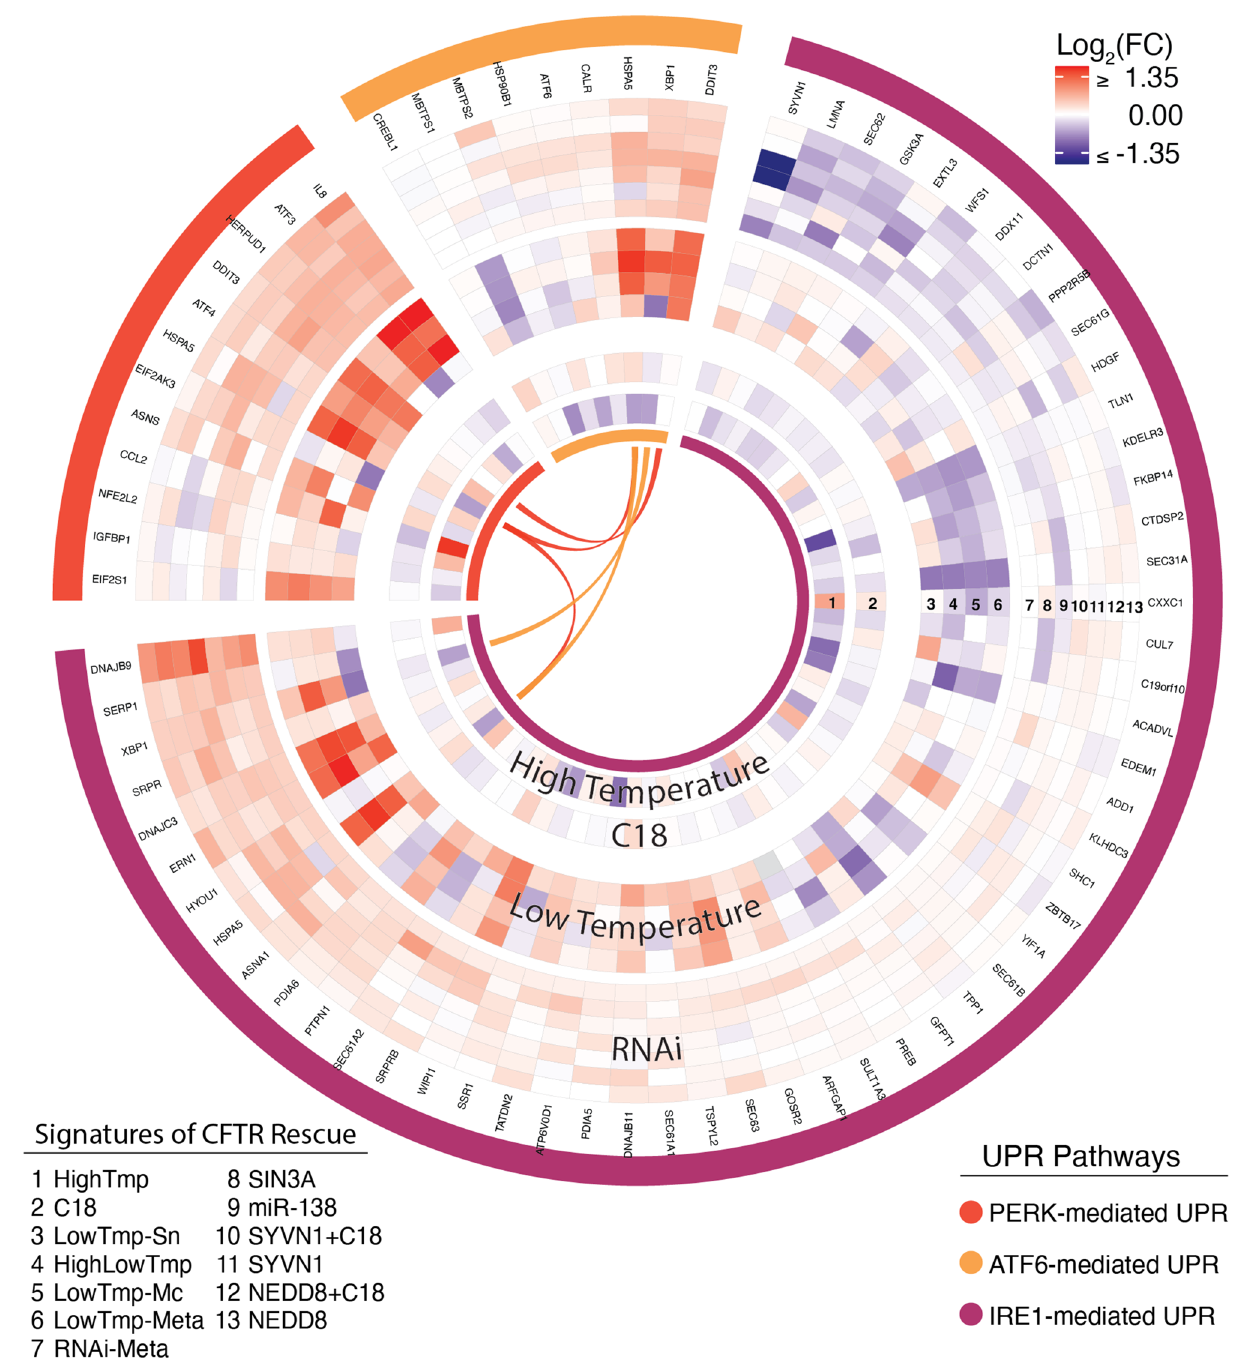
Figure 5. RNAi and low temperature, but not C18 or high temperature, induce consistent UPR transcriptional activation. “Columns” emanating from the center represent genes, which are grouped according to pathways, as indicated by the colors in the outermost circle. Concentric circles represent individual signatures and/or the core meta-analysis signatures, as indicated by the numbered legend. Arcs in the center connect genes that are shared between